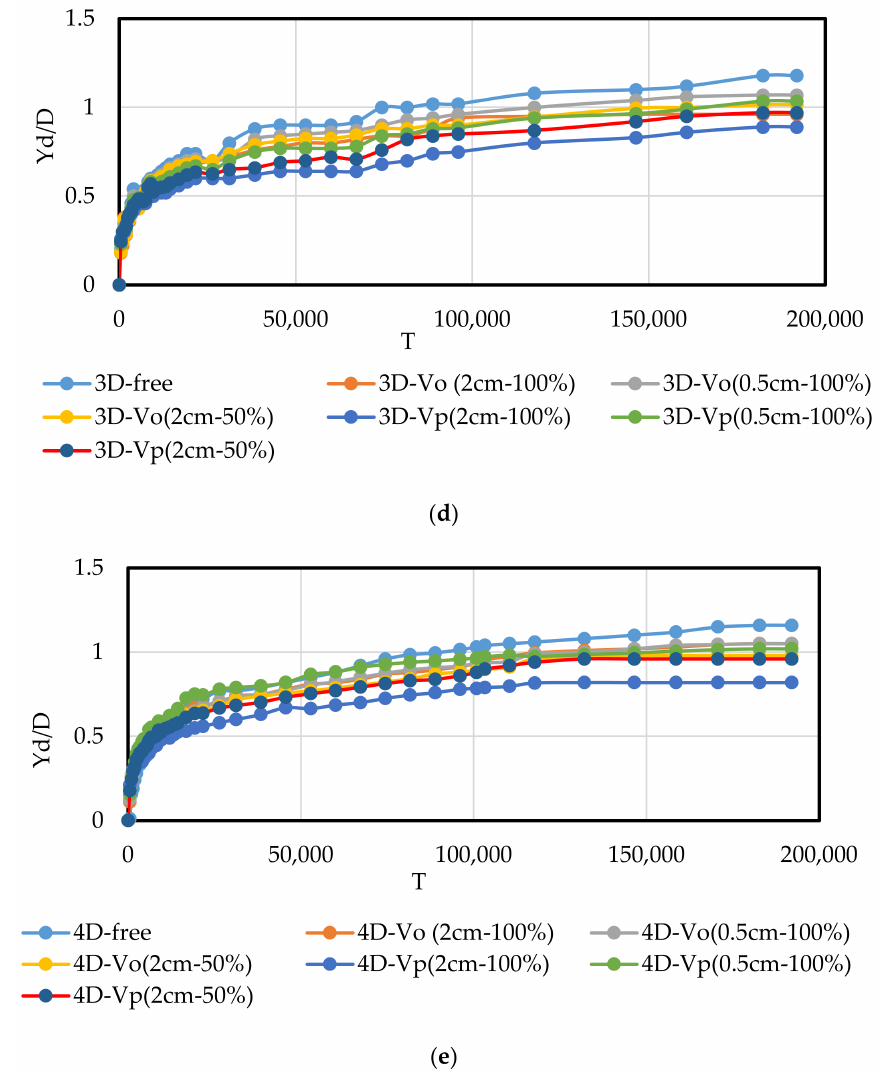
Figure 6. Scouring temporal development for ( a ) all cases free and with vegetation type 1, ( b ) single pile, ( c ) triple pile group with 2D distance, ( d ) triple pile group with 3D distance, and ( e ) triple pile group with 4D